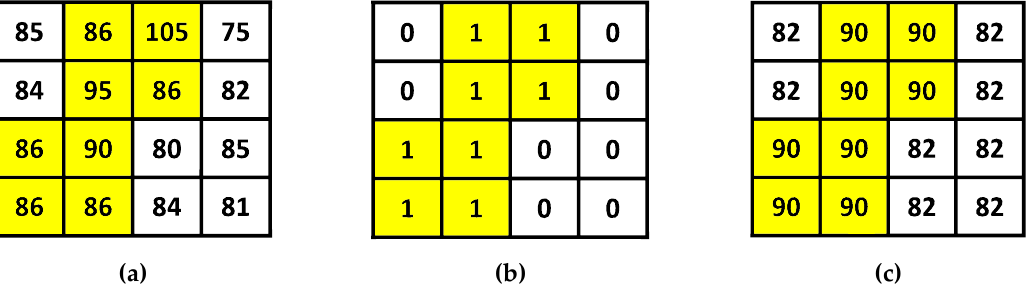
Figure 2. Illustration of the Absolute Moment Block Truncation Coding (AMBTC) compression. ( a ) Original image block, where the average pixel value x = 86 using (1). ( b ) The bit map used in AMBTC, where NH = 8 and NL = 8. ( c ) The AMBTC compressed block, where BS = 4, HM = 90, and LM = 82.